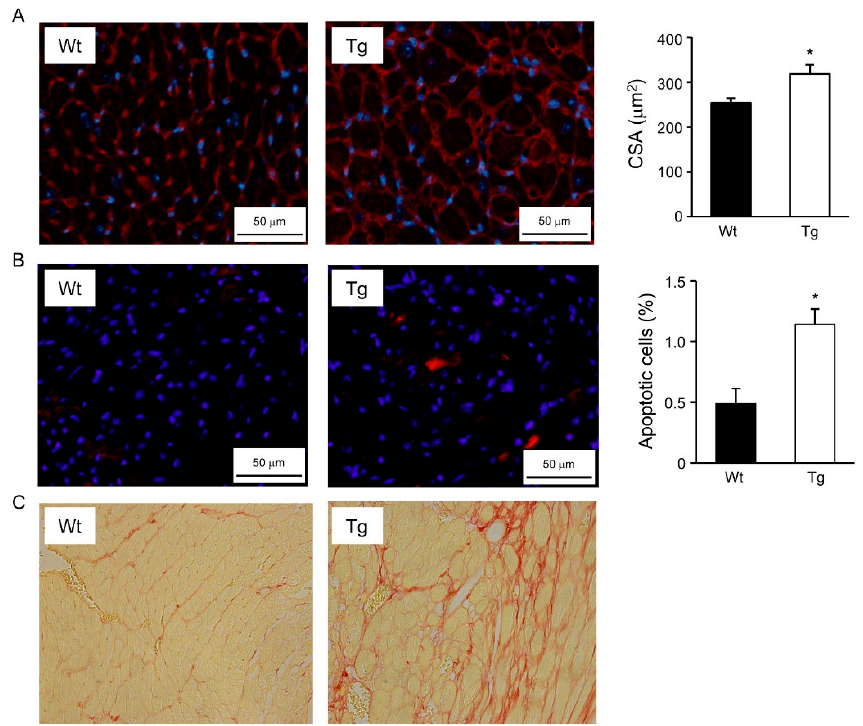
Figure 5. Cellular alterations in hearts of L6 hERR γ -Tg mice. ( A ) Cardiomyocyte cross-sectional area (CSA) was determined using the ImageJ software after staining heart sections with wheat germ agglutinin (WGA) conjugated with FITC. ( B ) Apoptosis was estimated by immunodetection with active caspase-3 (red). ( C ) Cardiac fibrosis was detected with the sirius red staining. Data are mean ± SEM of 3–4 animals/group; * p = 0.05.